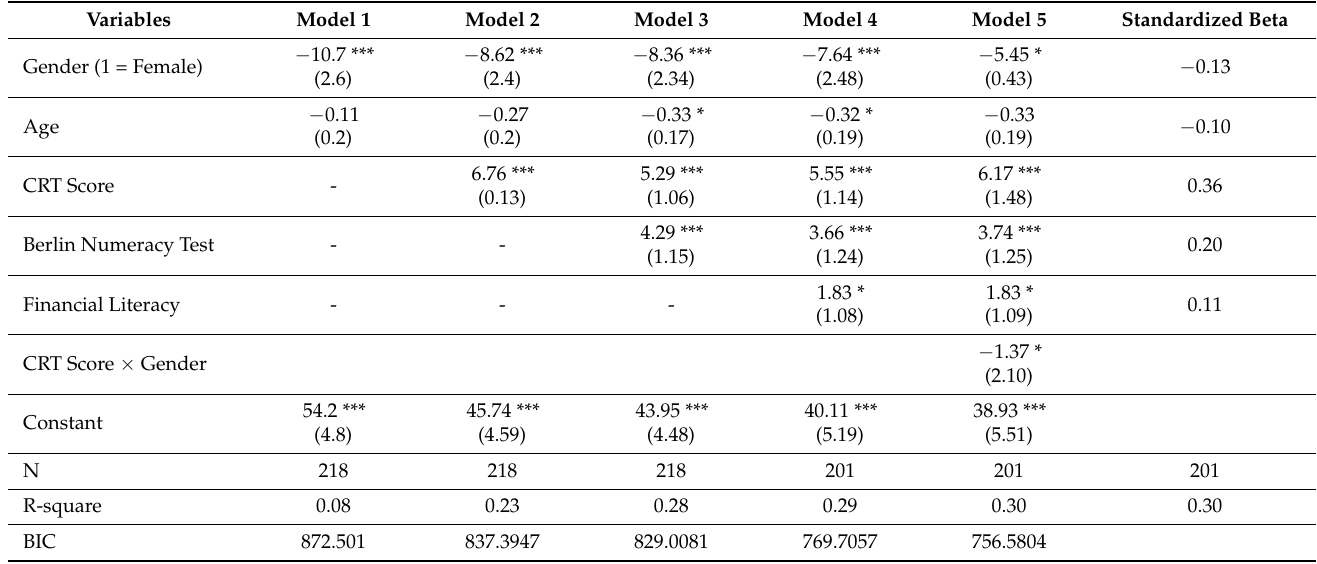
Table 6. Regression model for total